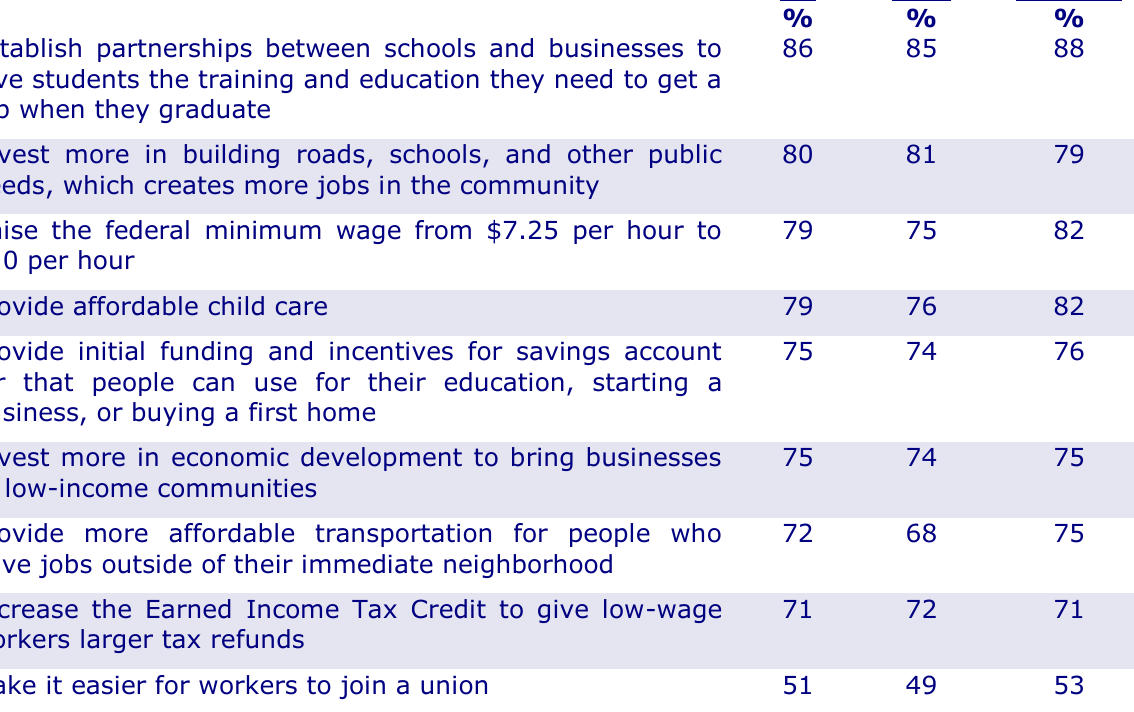
Table 10: Government Involvement Would Be Very or Fairly Helpful